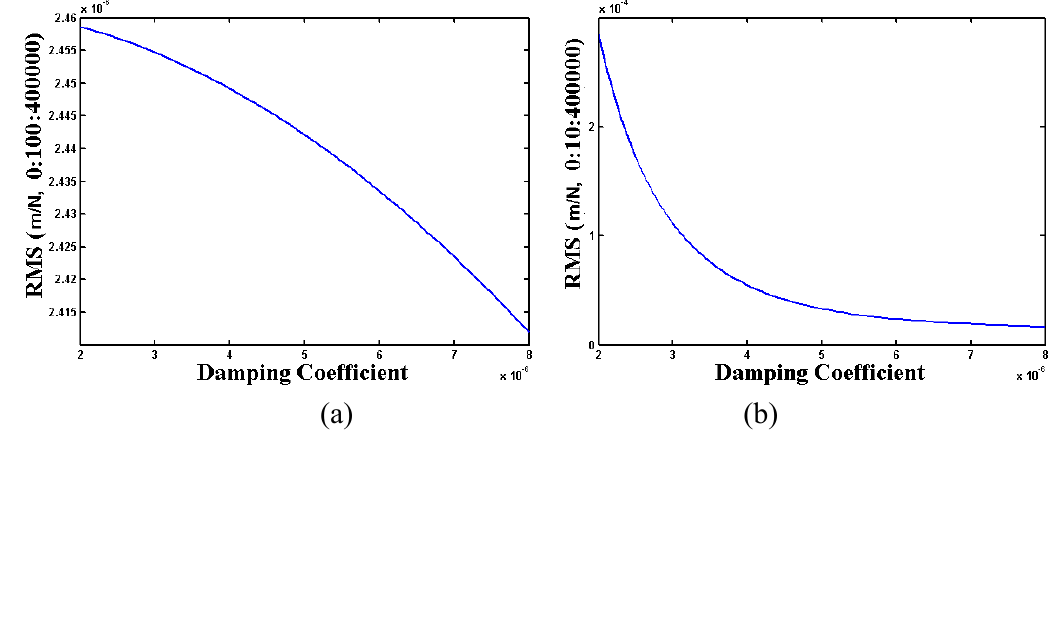
for different damping s